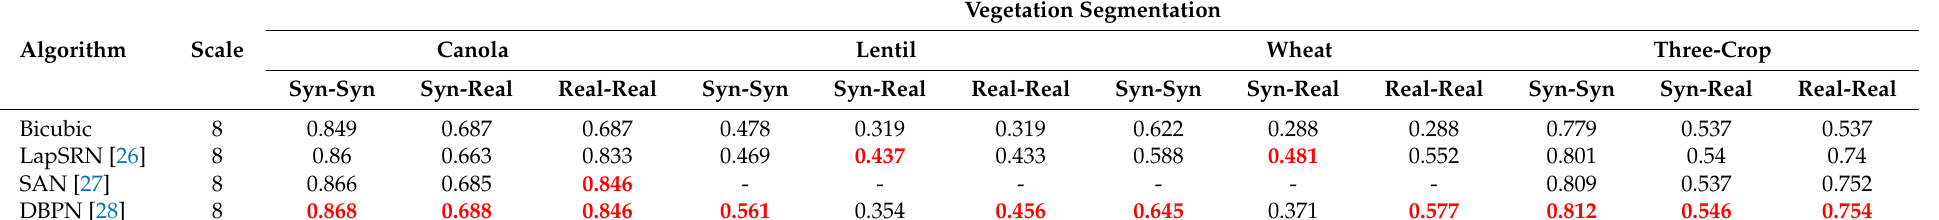
Table 6. Average vegetation segmentation DSC value for 8 values are indicated in red .